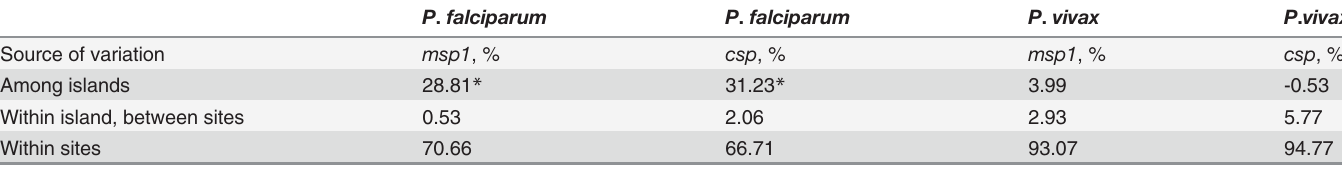
Table 5. Percentages of genetic variance partitioned at different population levels using analysis of molecular variance